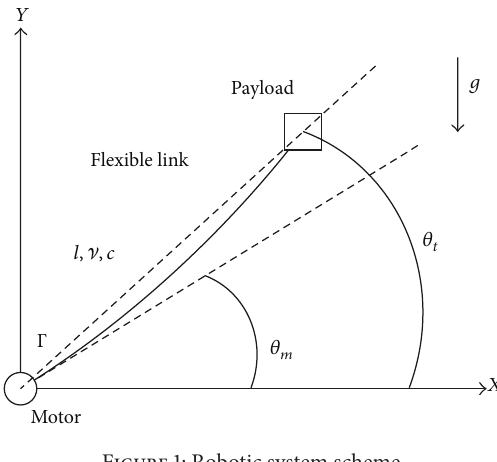
Figure 1: Robotic system